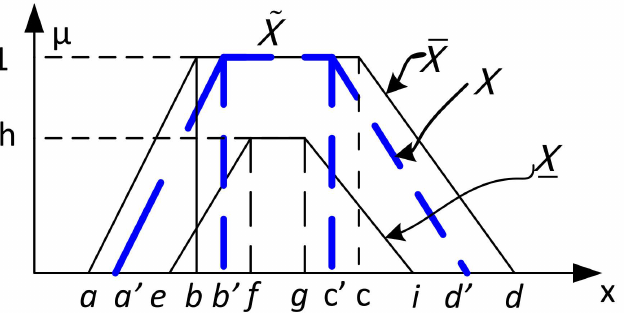
Figure 10. A trapezoidal T1 FS (thick dashed curve) and a trapezoidal IT2 FS, represented by nine parameters